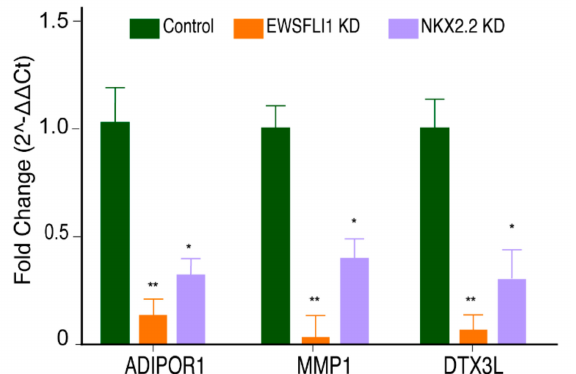
Figure 6. NKX2.2 regulates downstream targets of STEAP1: q-RT-PCR analysis of three downstream targets of STEAP1 in modified HTB166 cell lines. The fold change was calculated by normalizing the expression to a control cell line and with the expression of a GAPDH RNA as a housekeeping reference gene. Each experiment was done in triplicate. The error bars represent standard deviation. * p < 0.05, ** p < 0.01.